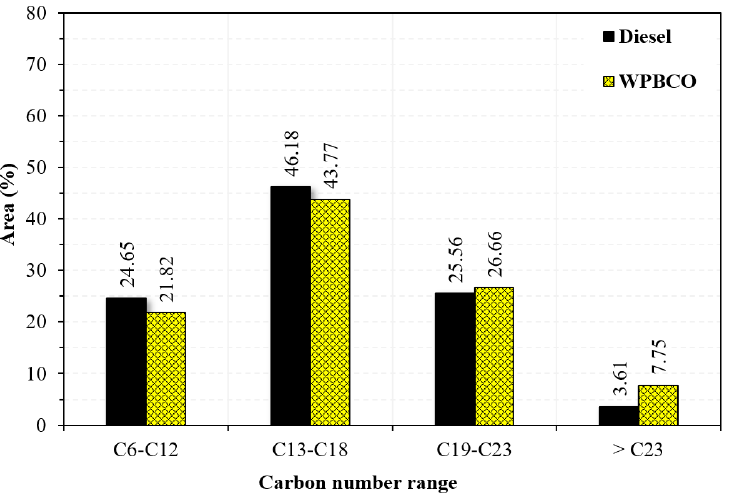
Figure 3. Carbon number range for diesel fuel and WPBCO by GC–MS analysis. Table 3. The identification and distribution of the compounds for diesel fuel.